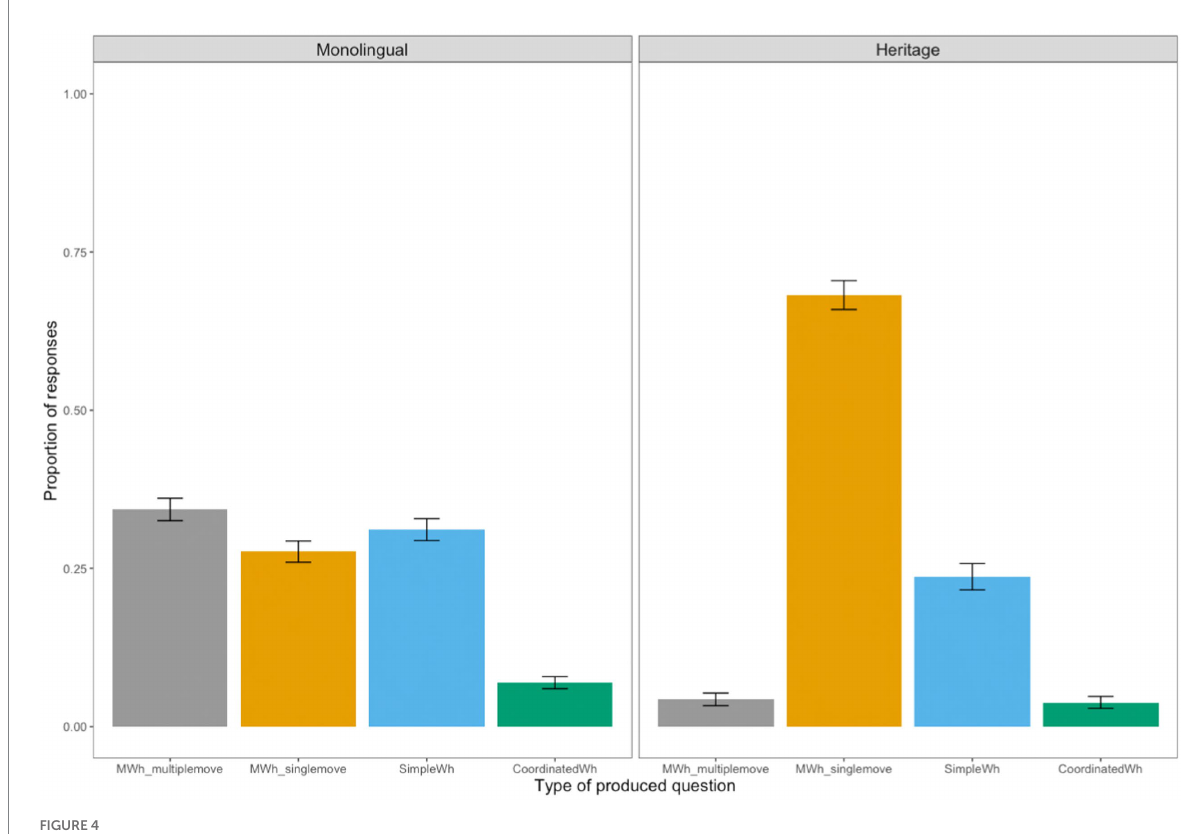
FIGURE 4 Overall distribution of responses per Group (Monolingual vs.